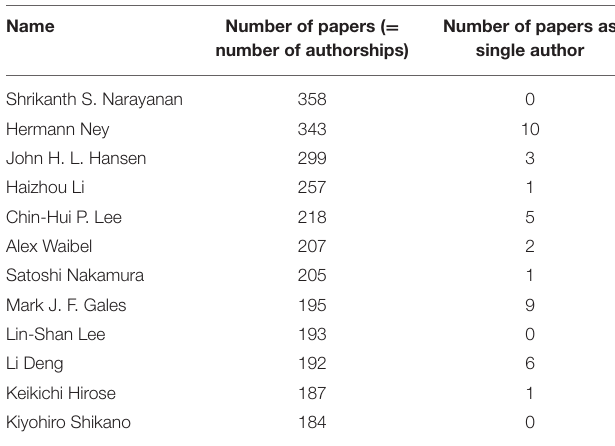
TABLE 3 | Ten most productive authors, including the number of papers published as single author.